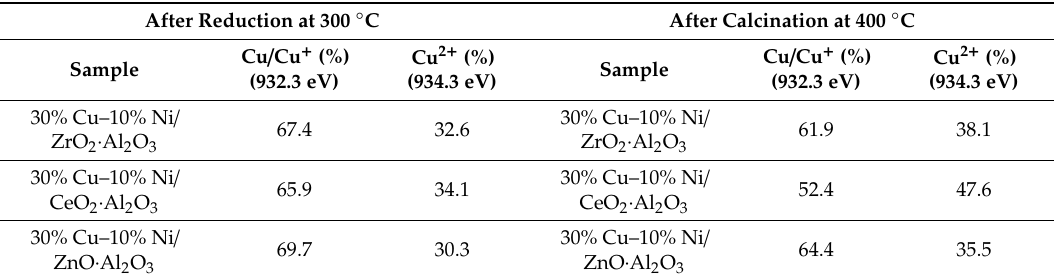
Figure 12. XPS spectra of ( a ) Cu 2p for various calcined Cu-Ni systems, ( b ) Cu 2p of various Cu-Ni catalysts reduced at 300 °C in a mixture of 5% H 2 in argon. Table 5. Atomic percentages of copper species Cu 2 + , Cu + and Cu 0 on the surface of the investigated calcined and reduced